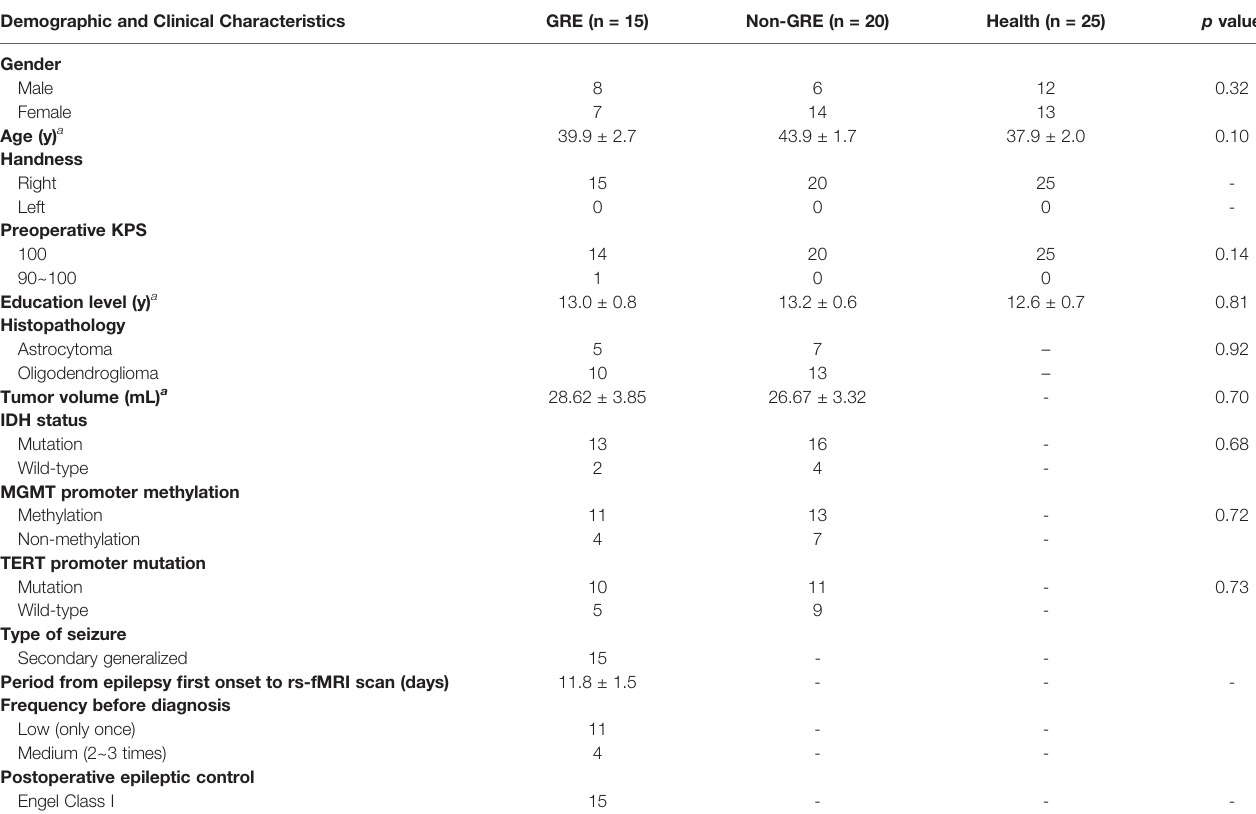
TABLE 1 | Demographic and clinical characteristics of patients with left prefrontal gliomas. Demographic and Clinical